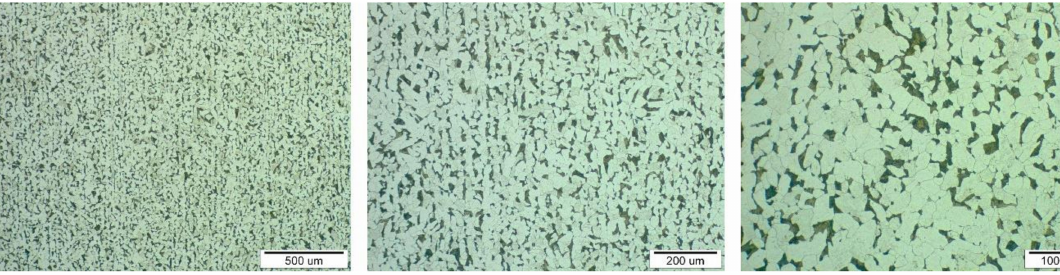
Figure 8. Sample microstructure in transverse direction (area B) at three di ff erent